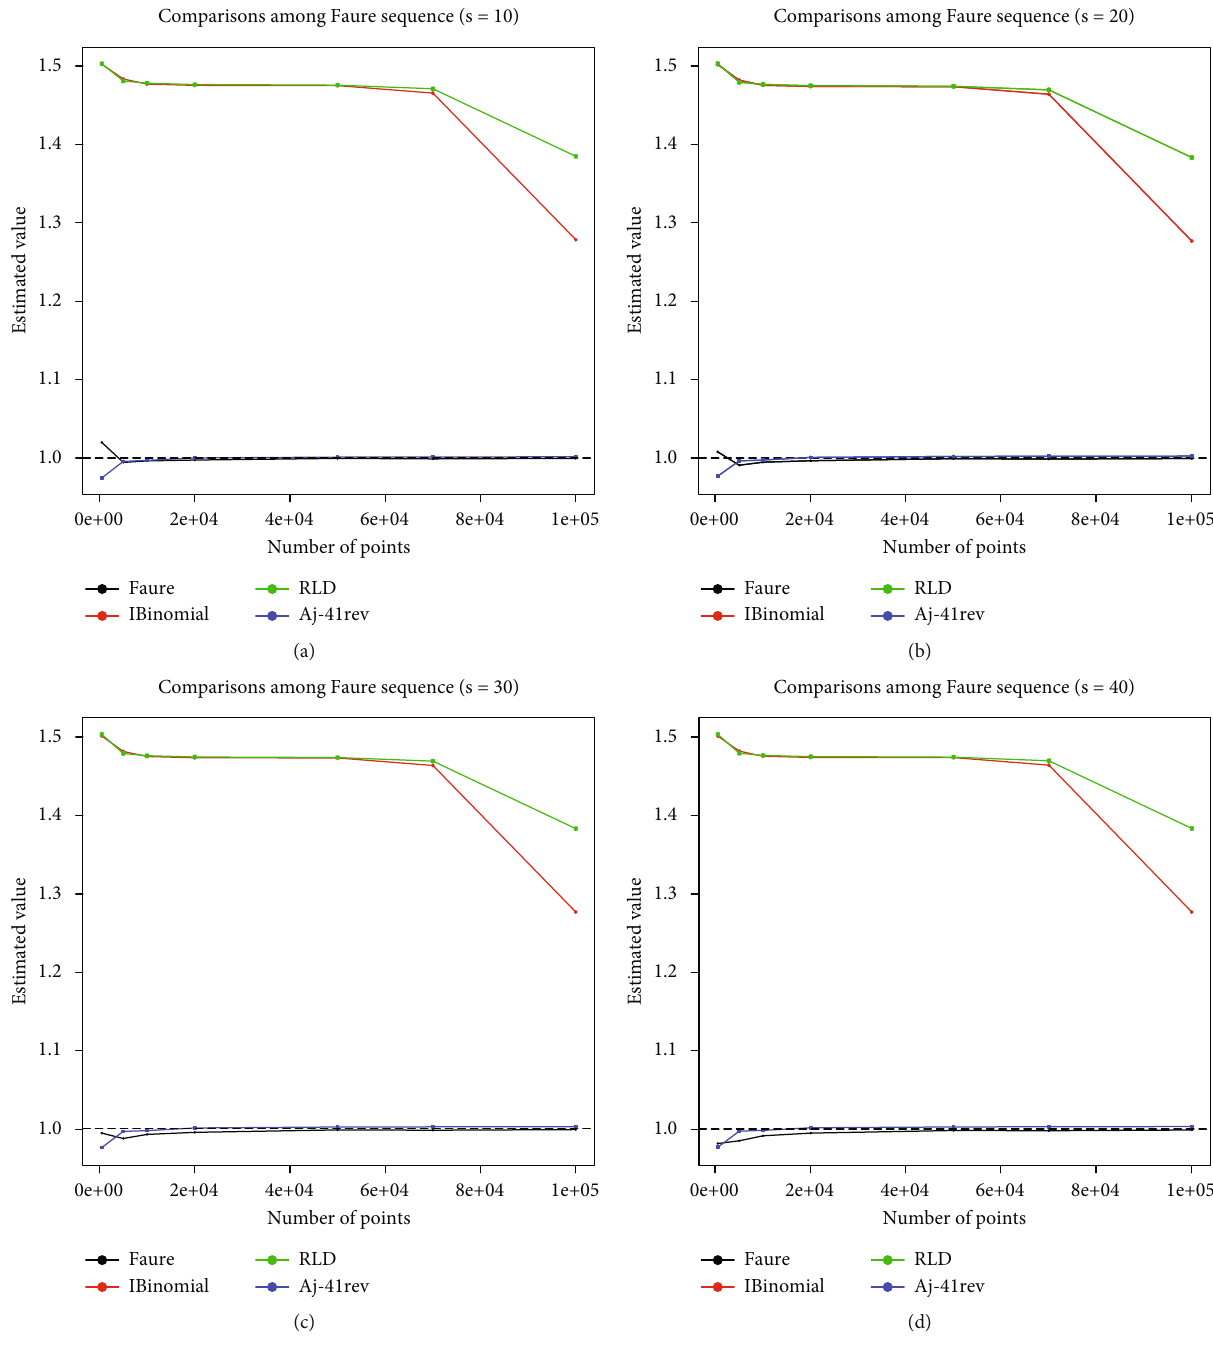
ð f Þ with a = i by using various Faure 2 i